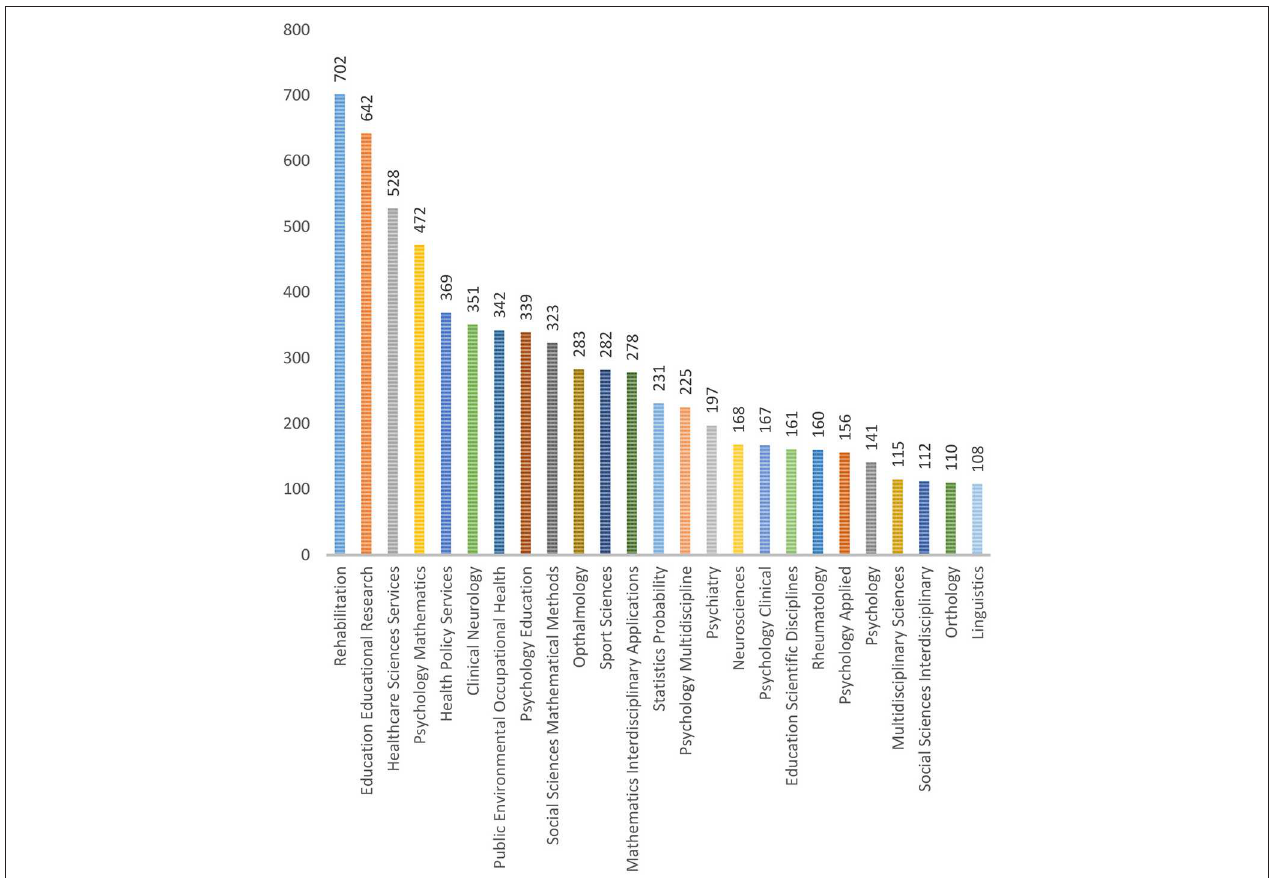
FIGURE 1 | Frequency of publications using Rasch measurement in different fields (Source: